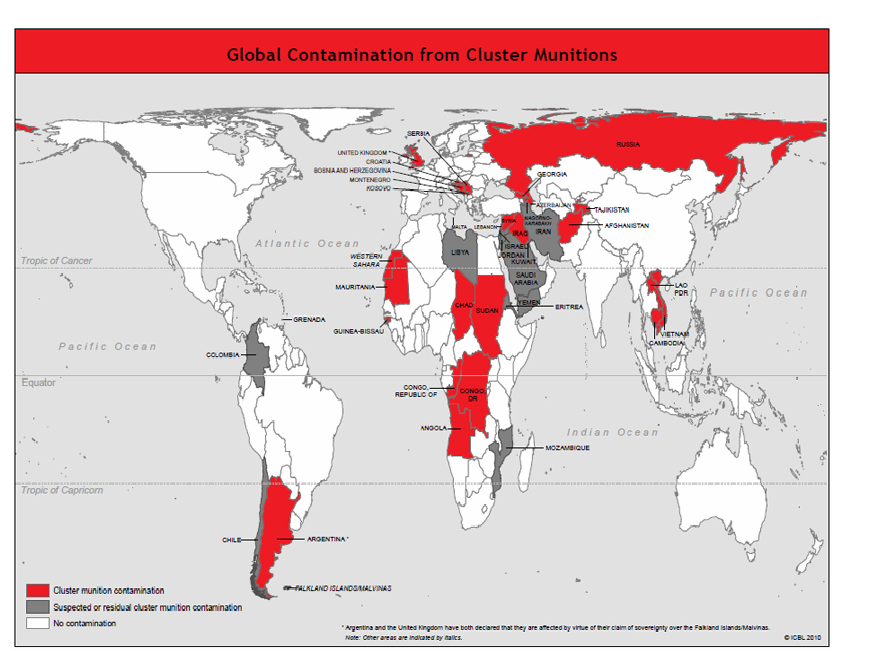
Figure 2 – Countries in which there is danger of cluster